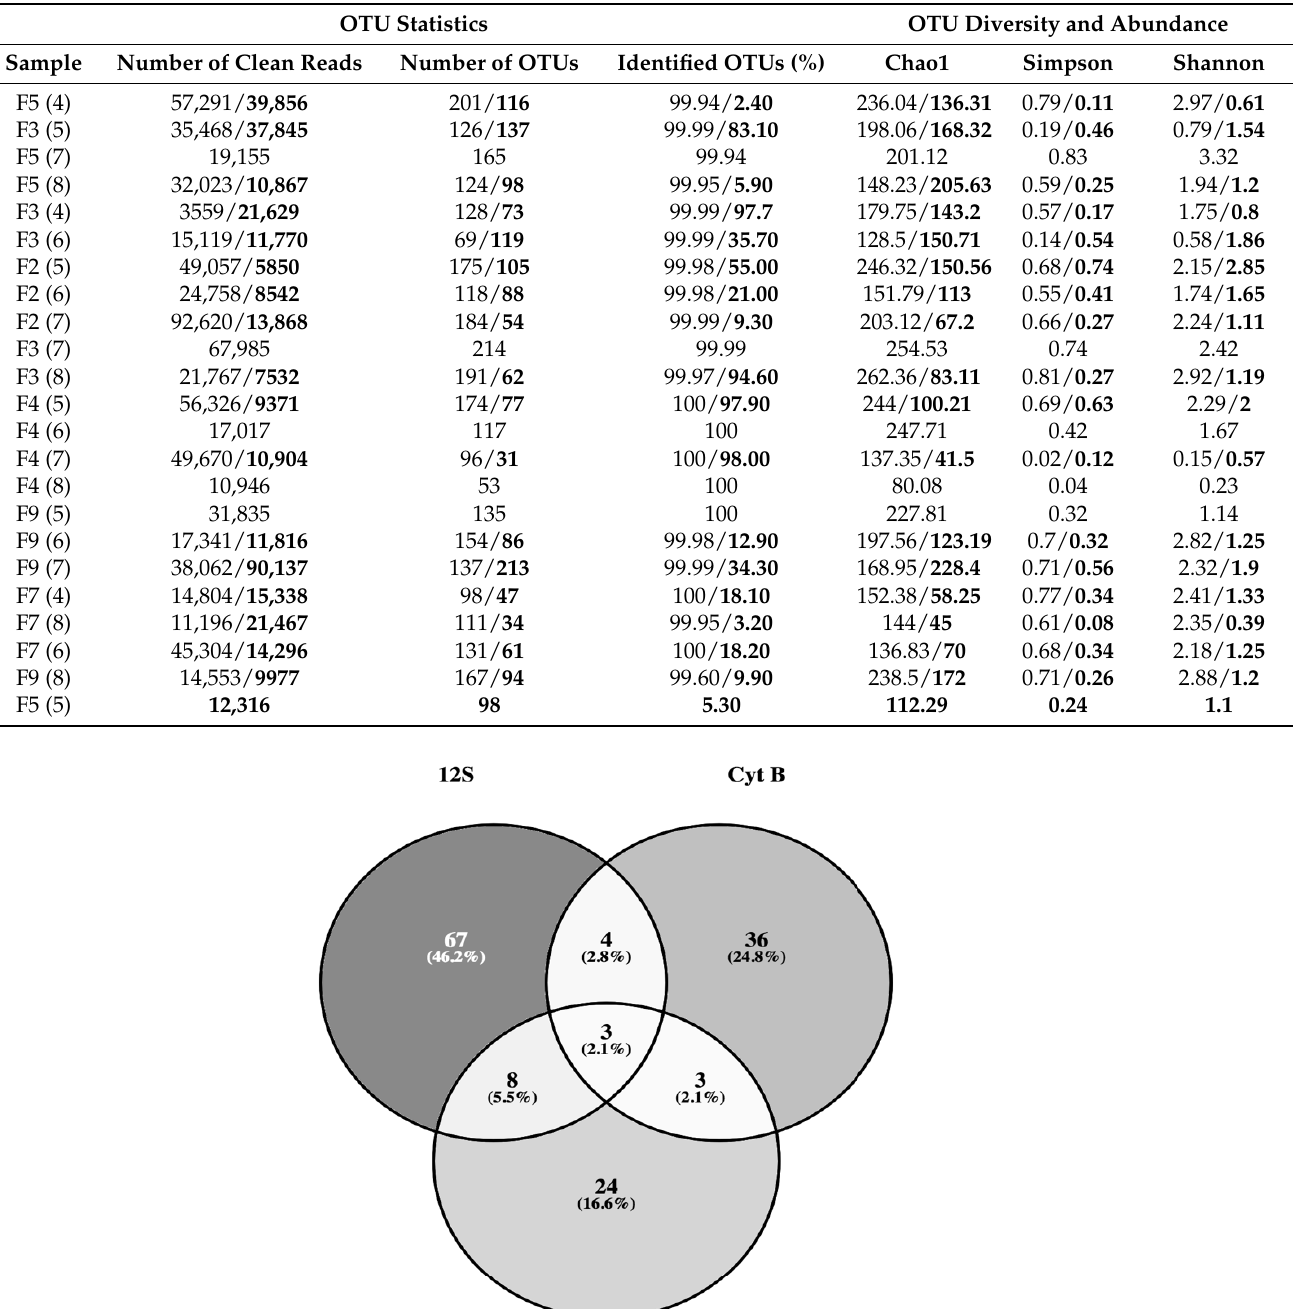
Table 2. 12S/Cyt b OTU statistics and alpha diversity indices for ichthyoplankton in Oujiang River Estuary. The value in parenthesis indicates sampling month (4–8 represents April–August). 12S— non-bold values above the slash and Cyt b—bold values below the slash.